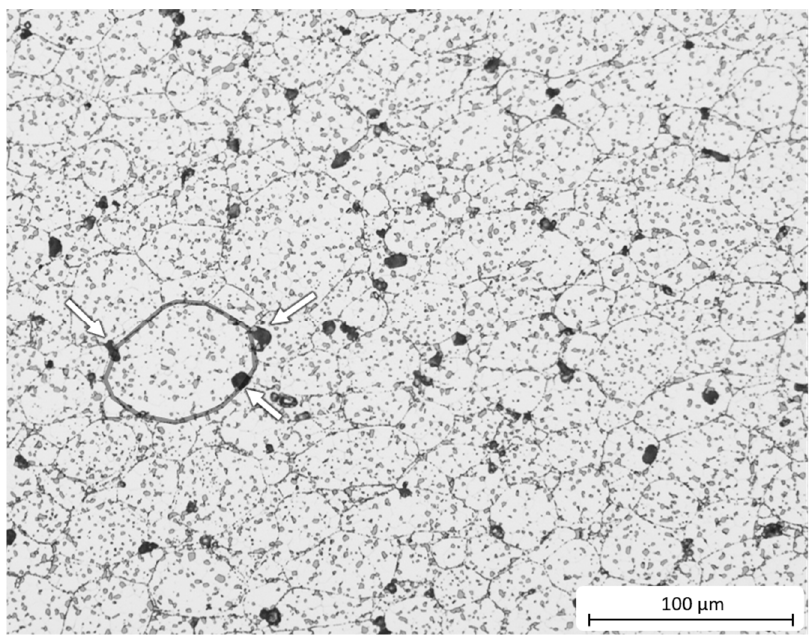
Figure 8. Optical micrograph of the heat-treated material etched with 10 Vol.-% hydrofluoric acid. Pores grew along the borders of former powder particles (encircled) and hence formed a network of chain-like pore paths.